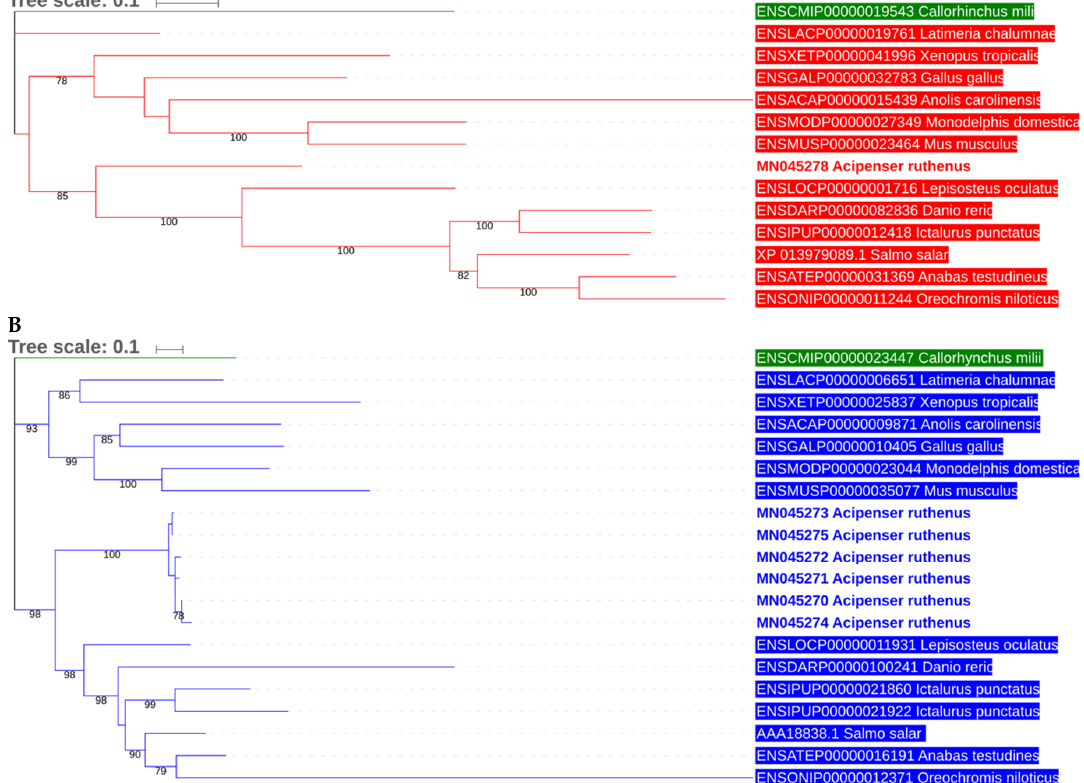
Figure 2. Phylogram showing the relationship of putative A. ruthenus transferrin isoforms with other transferrin sequences of related fish species and selected tetrapods. Panel A , melanotransferrin; panel B , serotransferrin. The ML phylogram was inferred by IQ-TREE with the guide/final tree inference (PMSF) strategy (see Material and Methods). The tree was rooted using sequences from Callorhinchus milii (Chondrichthyes, Chimaeriformes). Table 1. List of identified genes and their isoforms in the sterlet together with their NCBI accession numbers. * incomplete ORFs.